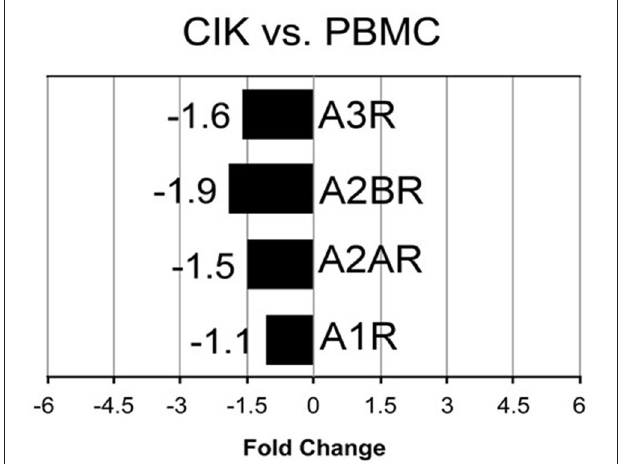
FIGURE 5 | Transcriptome analysis of P1 receptors in CIK cells. mRNA expression of A 1 R, A 2A R, A 2B R, A 3 R was analyzed in PBMC (day 1, absence of INF- γ ) and CIK cells (day 14) obtained from 3 GIST patients as described in Materials and Methods.